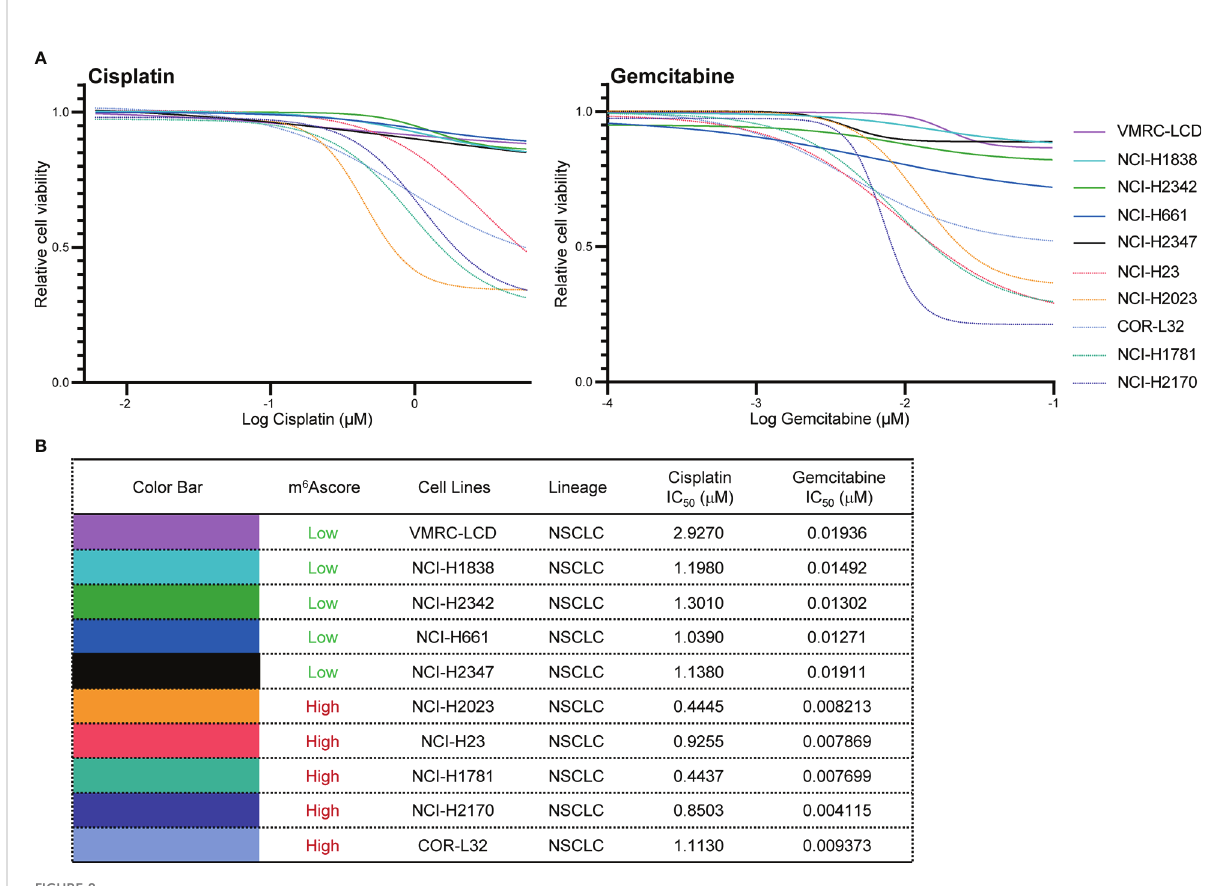
FIGURE 8 Validation of chemotherapy drugs ’ IC 50 . (A, B) Measurement of IC 50 by DNA dye or metabolic assay in NSCLC cell panels (VMRC-LCD, NCI- H1838, NCI-H2342, NCI-H661, NCI-H2347, NCI-H23, NCI-H2023, COR-L32, NCI-H1781, NCI-H2170) treated with Cisplatin and